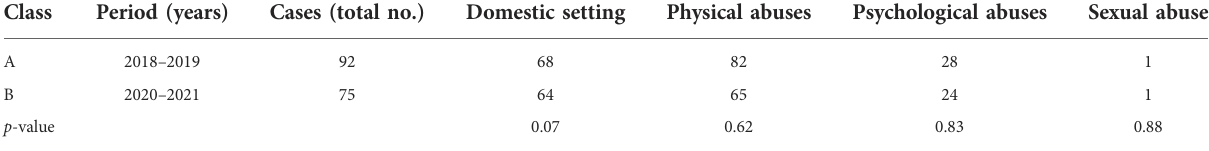
TABLE 3 Statistical comparison between cases occurred in 2018 and 2019 (A) and cases occurred in 2020 and 2021